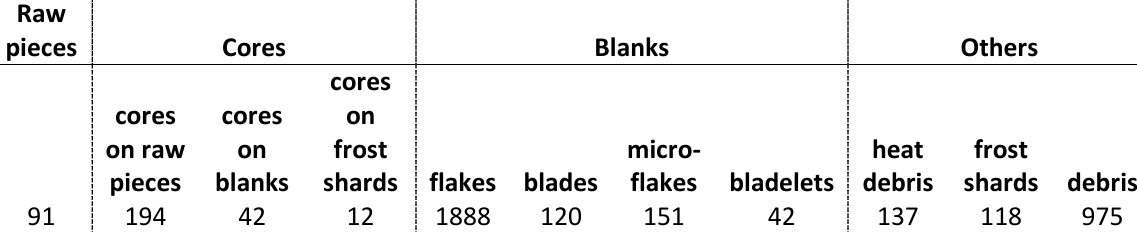
Table 3. Clusters of lithic objects from GH 3, all raw materials